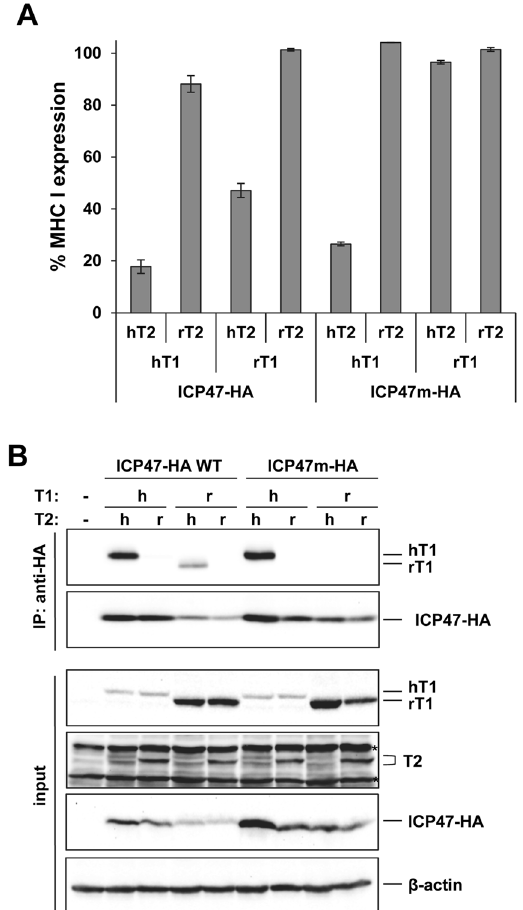
Figure 4. Interaction with the human TAP2 subunit is required for inhibition by ICP47. ( A ) Mouse CMT64.5 cells stably expressing TAP1, TAP2 and ICP47-HA or ICP47m-HA were analyzed by flow cytometry using the MHC class I specific antibody 20-8-4 recognizing H2-K b and H2-D b . The diagram shows relative MFI values of EGFP positive cells (ICP47 positive) compared to the EGFP negative (ICP47 negative) cells in the same sample. Mean values of two independent experiments is shown. ( B ) The cells from A were lysed in digitonin lysis buffer and an IP was performed using anti-HA antibodies. Aliquots of the lysates (input) and recovered proteins (IP) were separated by SDS-PAGE and detected in Western blot (TAP1, 148.3; ICP47-HA, anti-HA; TAP2, anti- FLAG). Original blots are shown in Fig. S7B. A replicate of the experiment is shown in Fig.